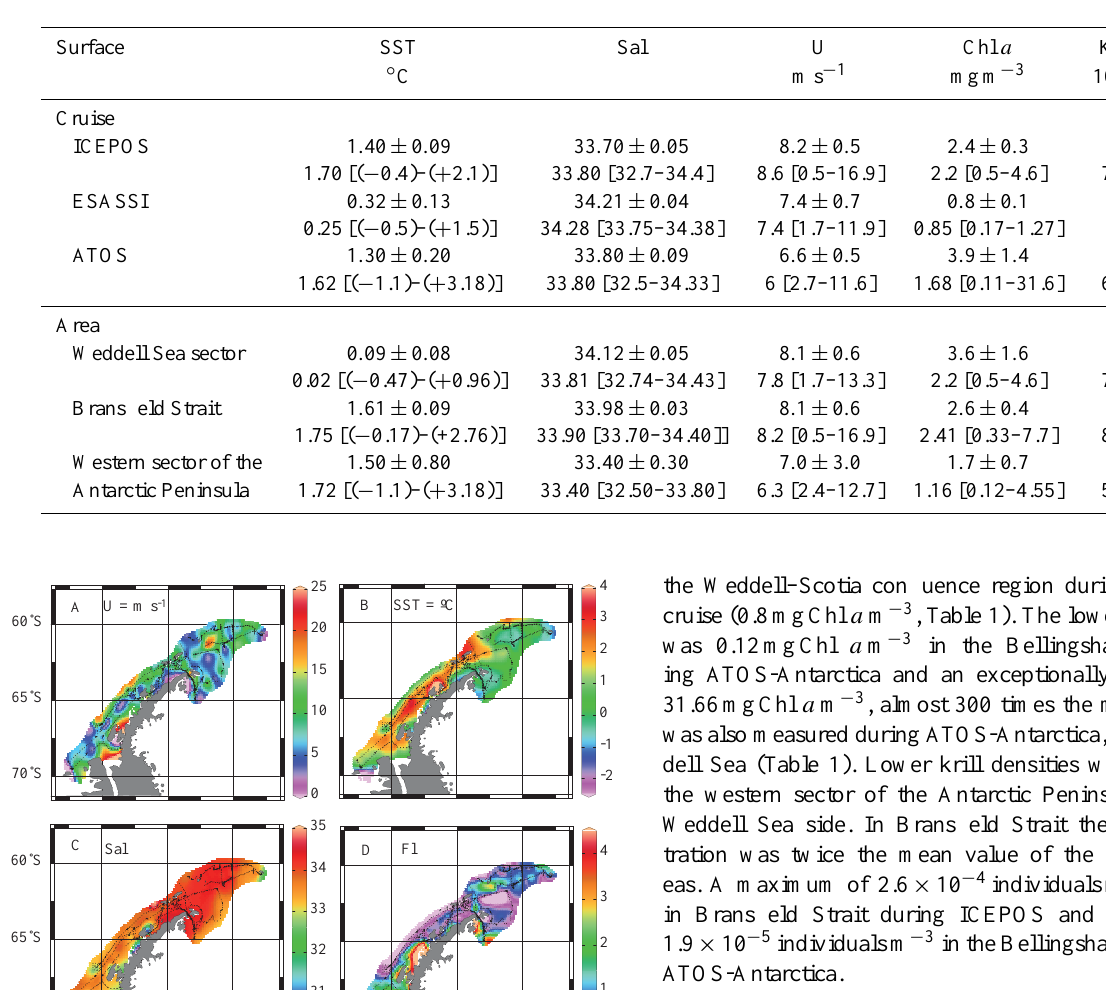
Table 1. Mean ± standard error (SE), median and ranges for the physical and biological parameters measured at the stations where coupled EDOC–GOC measurements were taken. Data for all three cruises: ICEPOS in 2005, ESASSI in 2008 and ATOS-Antarctica in 2009. Data were grouped into cruises and areas. Note that means for the different areas were estimated from the three cruises. There were no acoustic data to estimate krill density for the ESASSI cruise.